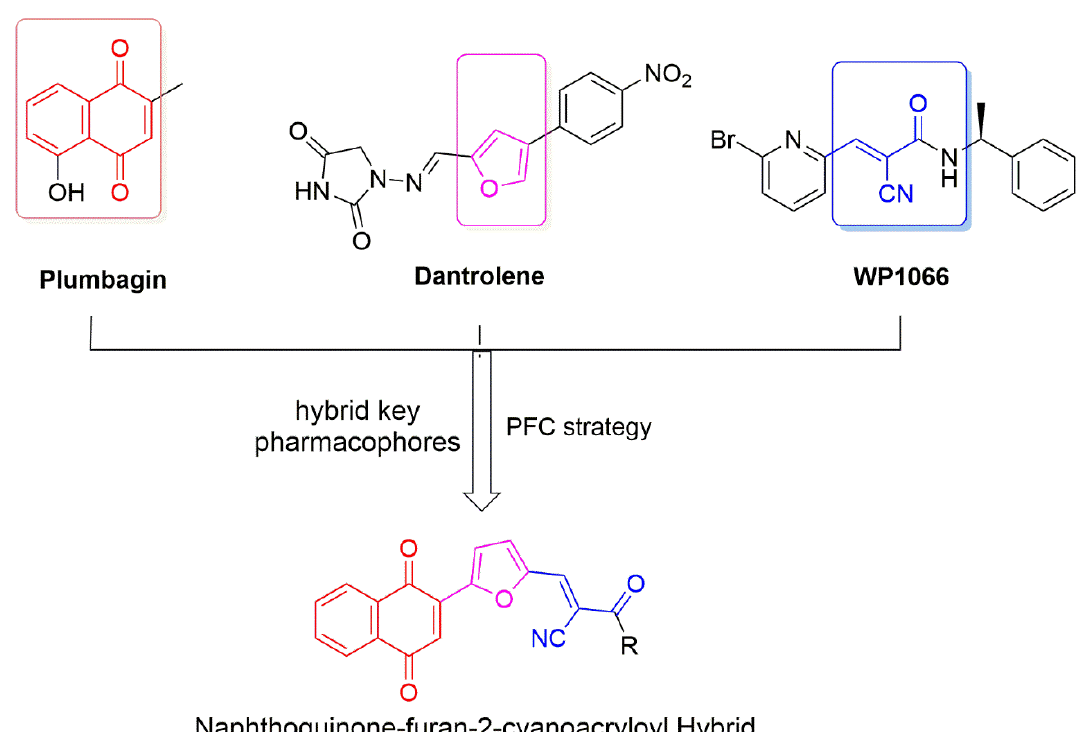
Figure 3. The design of novel naphthoquinone-furan-2-cyanoacryloyl hybrid.